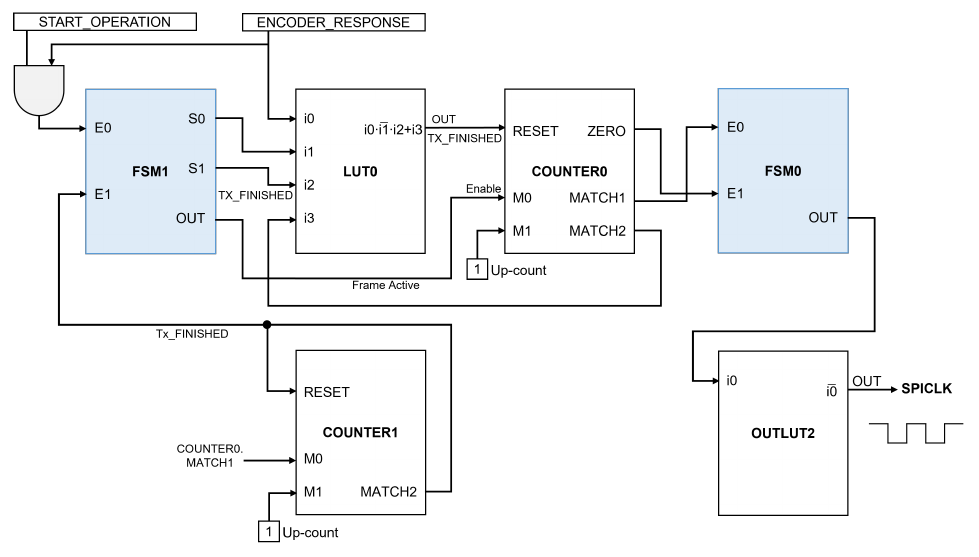
Figure 12. CLB structure for SPICLK generation.